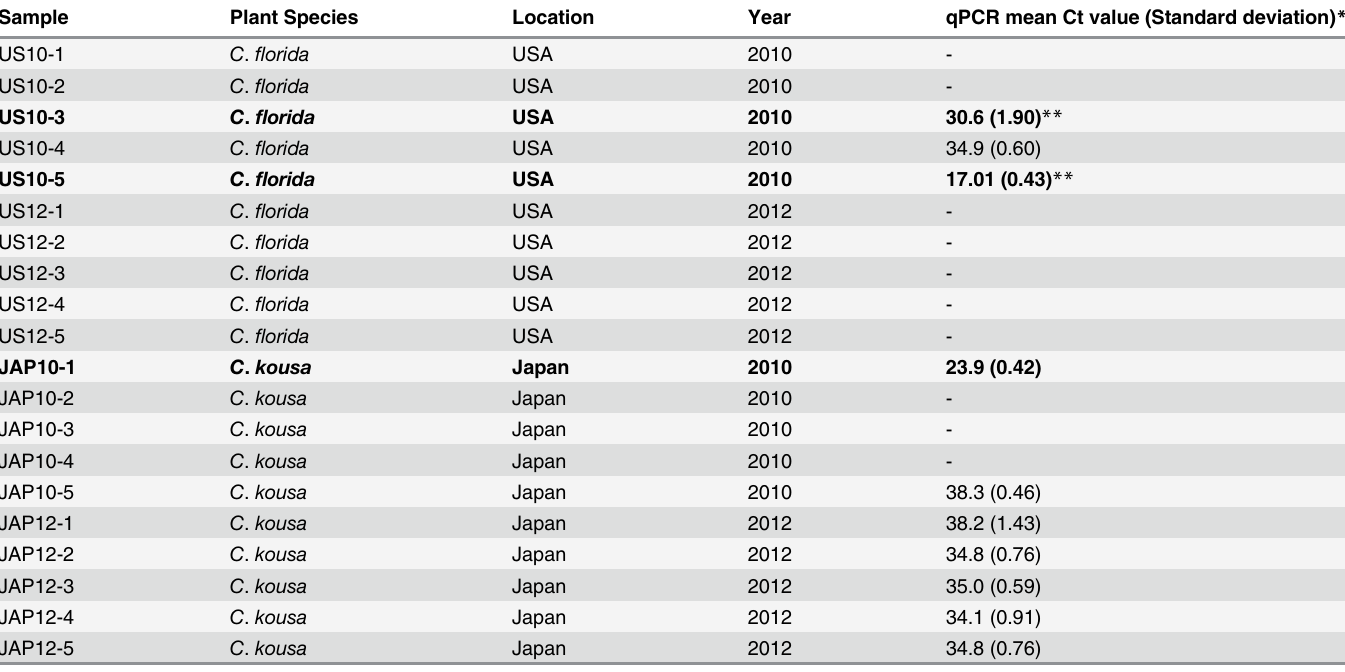
* Highlighted in bold are the samples with positive detection of Discula destructiva , with Ct value < 32.0, and con fi rmed with DNA sequencing. -: no ampli fi cation signals. ** Cultures of Discula destructiva were also obtained from these